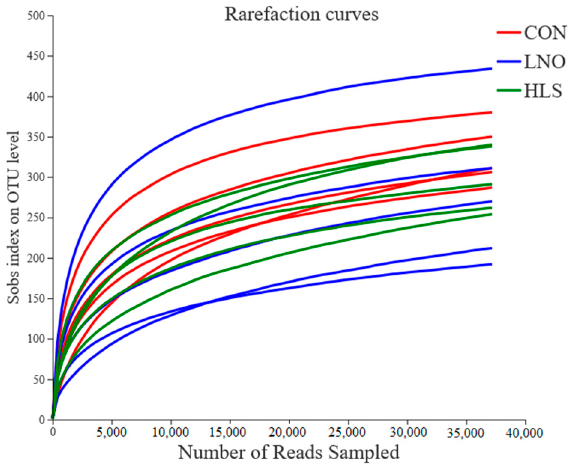
Figure 1. The OTU rarefaction curves of the ileum digesta bacterial communities. Curves were drawn using the least sequenced sample as the upper limit for the rarefactions. Each color represents one treatment: The red curves represent kids fed the basal diet (CON), the blue curves represent kids fed the basal diet supplemented with flaxseed oil (LNO), and the green curves represent kids fed the basal diet supplemented with heated flaxseed grain (HLS).